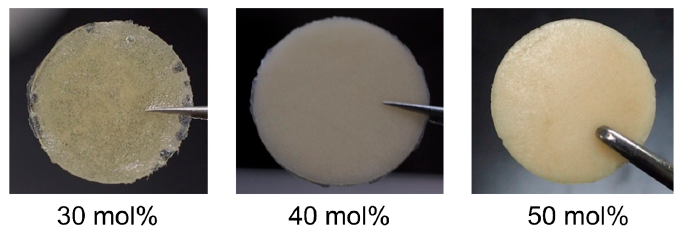
Figure 5. Cellulose/IL (ionic liquid) composite films (30–50 mol %) with a diameter of 25 mm and thickness of 1 mm. The opacity of the film of 40 mol % is attributed to micro air bubbles [9] and surface